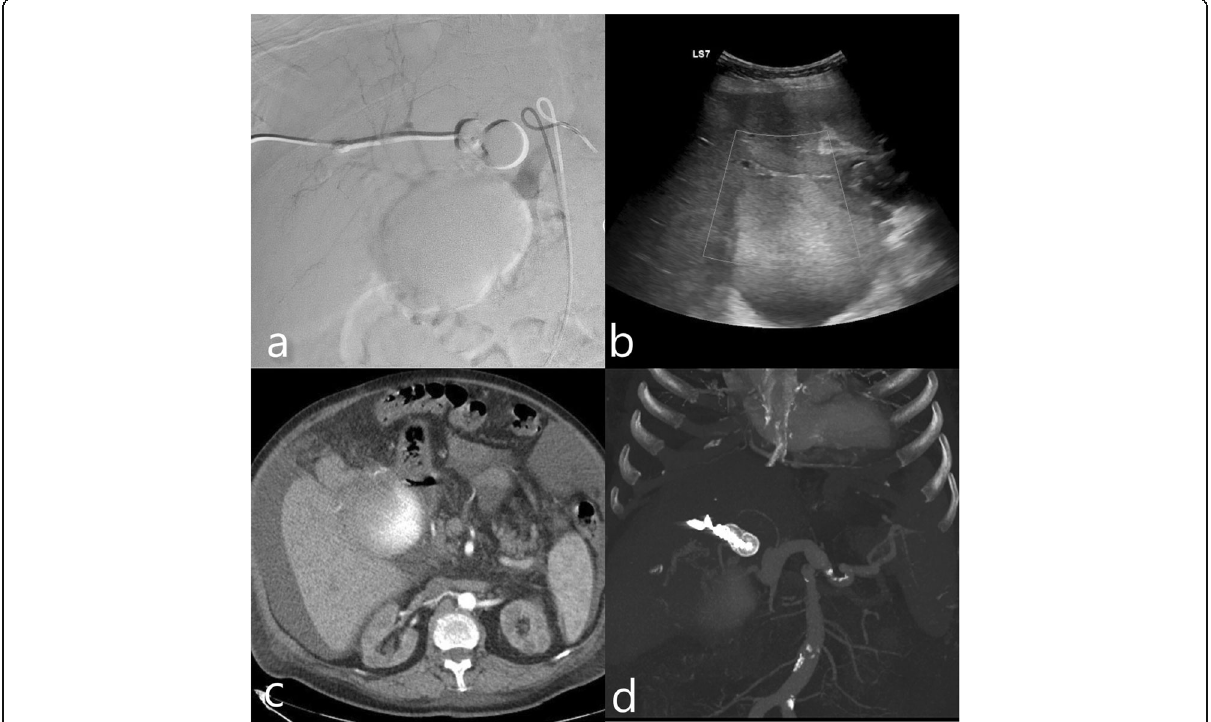
Fig. 3 Celiac angiogram and US images ( a - b ) showing immediate thrombosis formation in the portal vein and aneurysm sac while preserving hepatic artery circulation. One month follow up triphasic CT( c - d ); arterial phase shows no filling of the portal vein and aneurysm sac following the AVP II; coils deployed through the access site can be